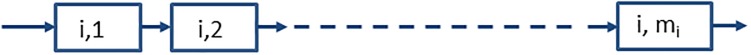
Failure by the ith path at time t requires an ordered sequence of failures, with the last failure at time t (Eqs 16 and 18).